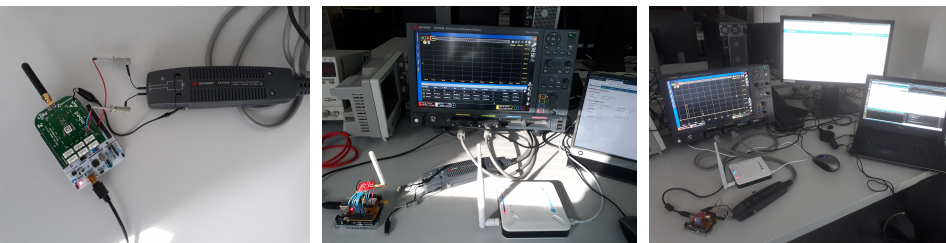
Figure 9. Experimental testbed to measure currents consumed by a LoRa shield of an IoT